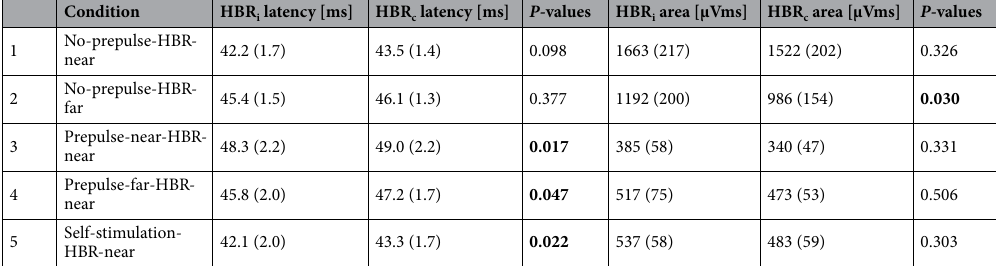
Table 1. Hand-blink reflex parameters for recordings ipsi- and contralateral (HBR i , HBR c ) to median nerve stimulation. Figures are the mean values (standard error within parenthesis) for group average data of individual absolute mean values. P -values indicate differences between HBR i and HBR c (paired